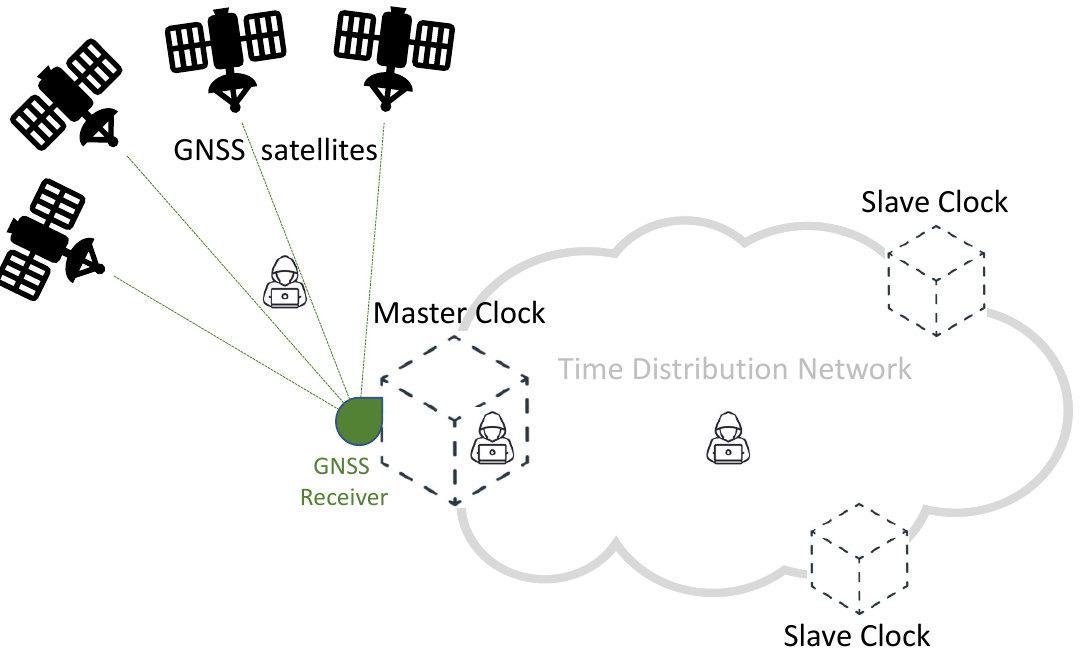
Figure 1. Simplified scheme of a GNSS-based time distribution